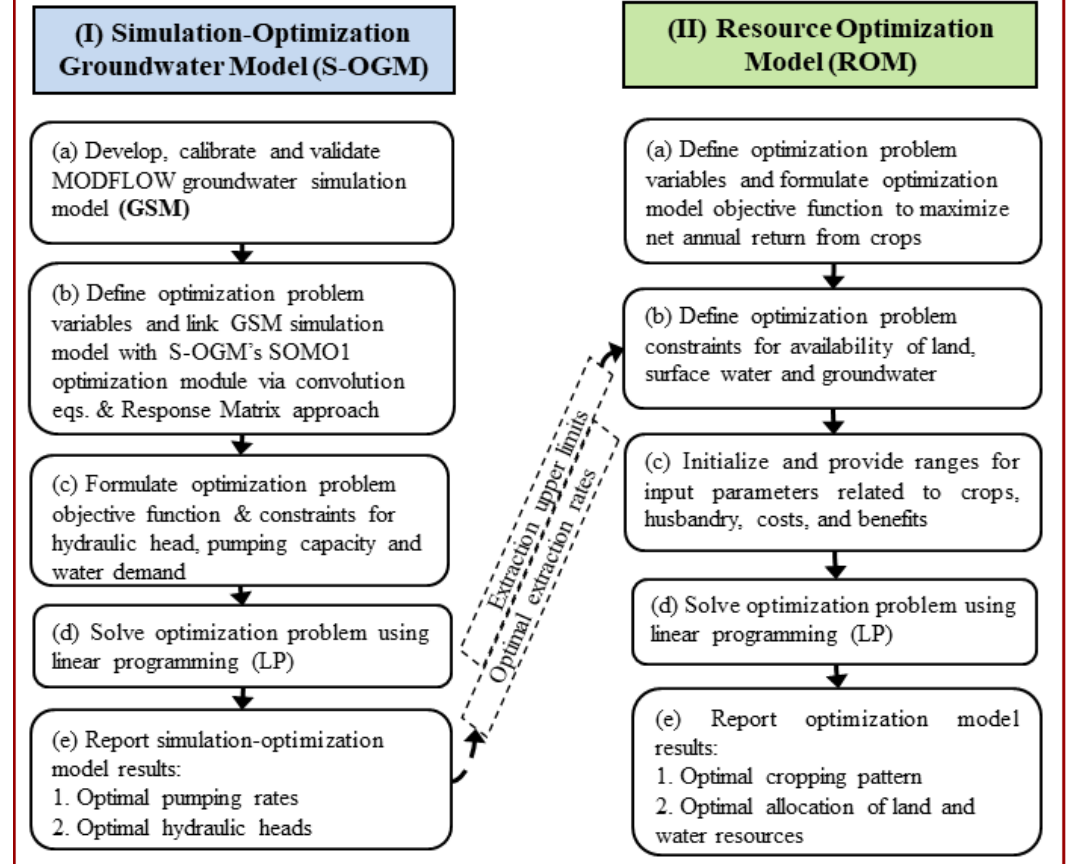
Figure 3. Schematic representation of integrated modeling framework for optimal land and water resources allocation to crops: (I) Simulation-Optimization Groundwater Model (S-OGM) for computing optimal groundwater abstraction strategies; and (II) Resources Optimization Model (ROM) for determining optimal cropping patterns and land and water resources allocations.